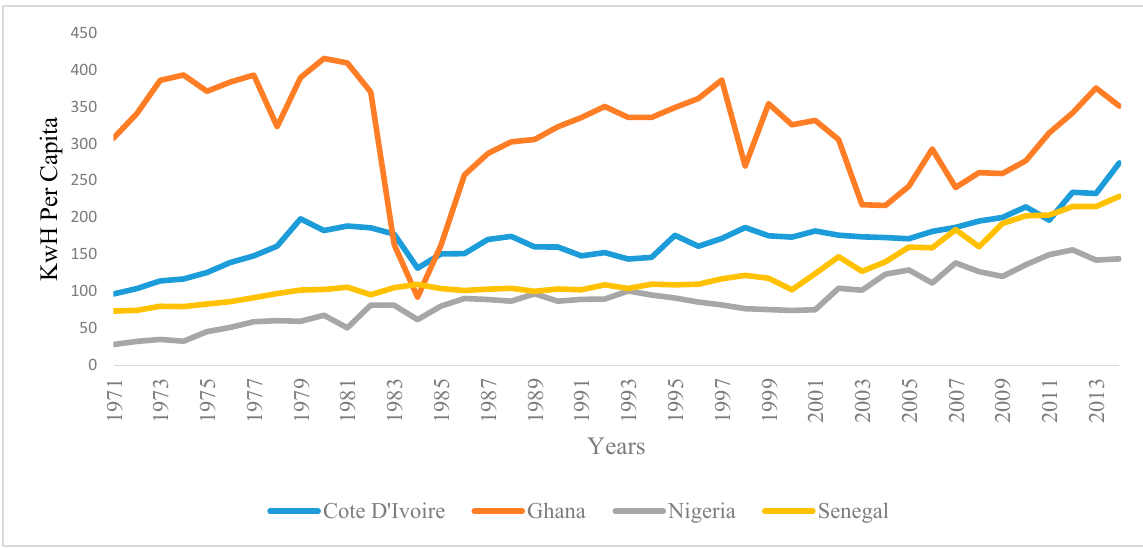
Figure 1. Energy consumption trends. Source: Adapted from [18,19].